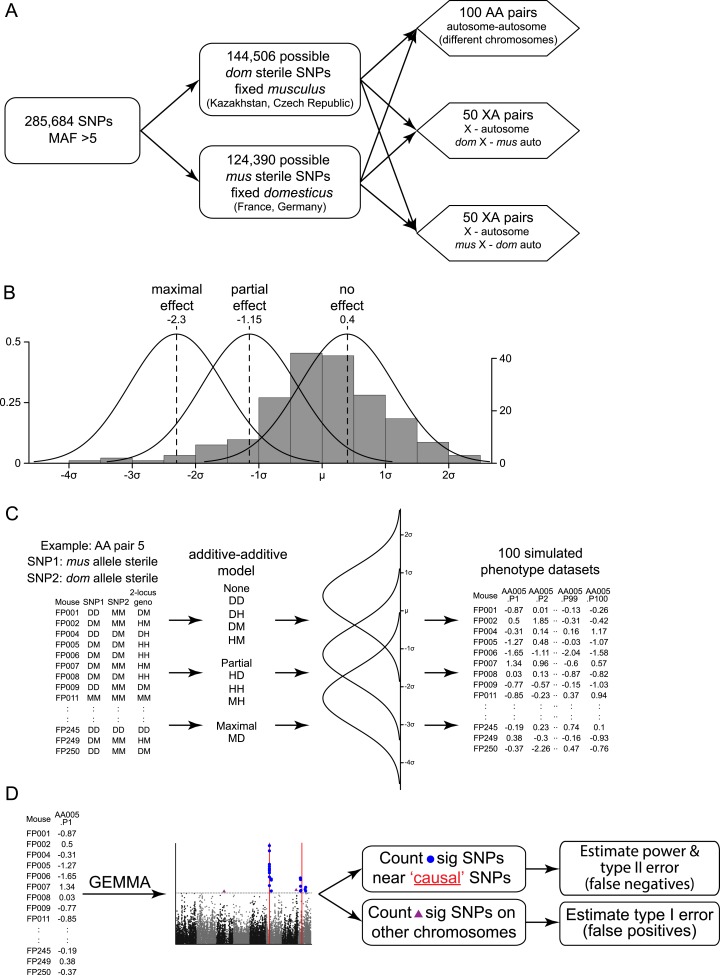
Mapping simulation methods.Schematics of (A) choice of ‘causal’ SNP pairs from the genotype data, (B) phenotype distributions for simulations, (C) generation of simulated phenotype data sets, (D) association mapping. In (B) histogram shows the empirical distribution of relative testis weight in the mapping population, in standard deviation units.